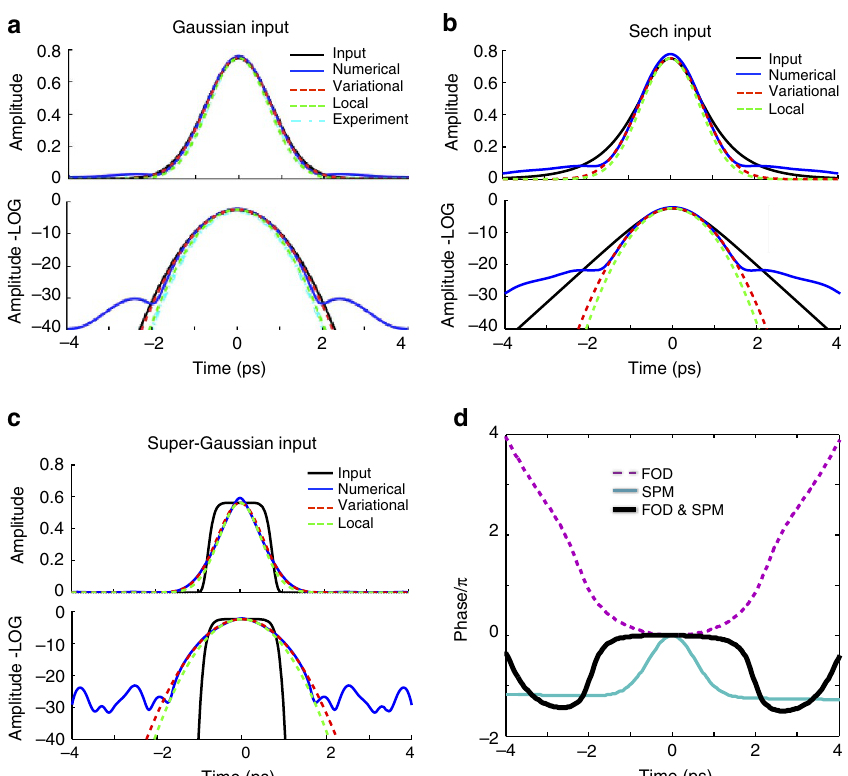
Figure 4 | Approximate solutions to a fundamental pure-quartic soliton and phase diagram. Comparison between the variational and local approximate solutions for the fundamental pure-quartic soliton and the numerical output after propagating over thirty quartic dispersion lengths for ( a ) a Gaussian input, ( b ) a hyperbolic secant input, and ( c ) a super Gaussian input of order 4. In the Gaussian case the measured output pulse at 0.7W is shown in the background (dot-dash cyan curve). ( d ) Phase shift induced by the fourth-order dispersion (dashed purple) and the self-phase modulation (solid turquoise) independently and its combined phase shift